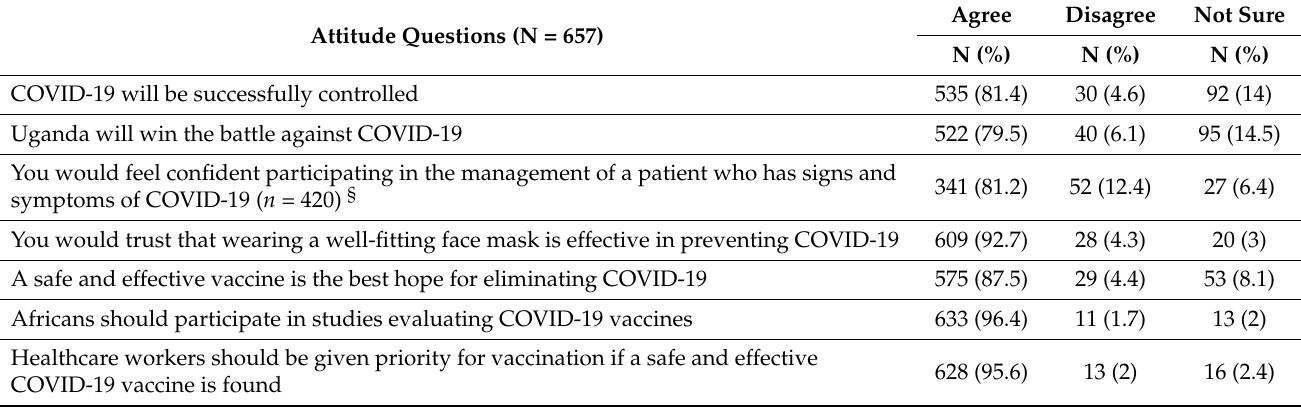
Table 3. Descriptive summary of COVID-19 attitudes among HCWs in